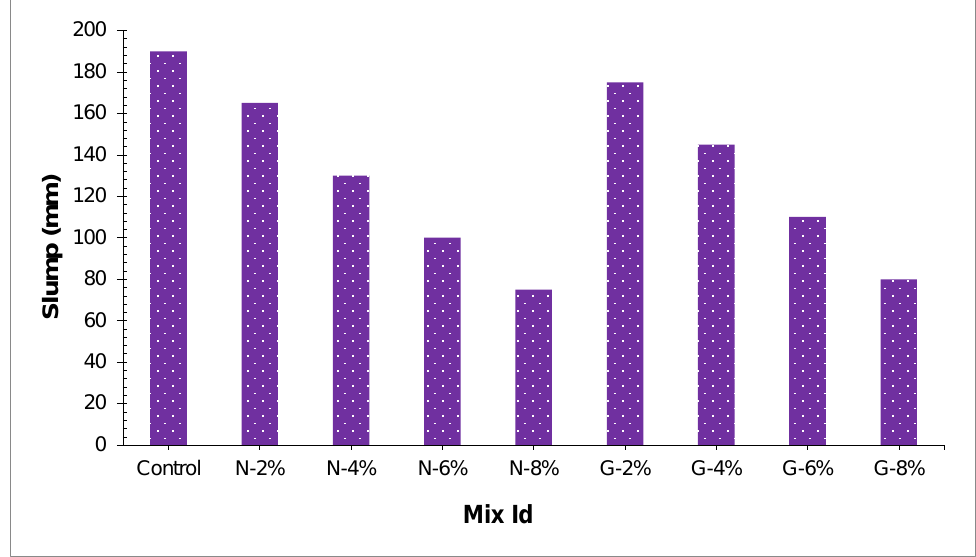
Figure 3. Slump values of fresh concrete.